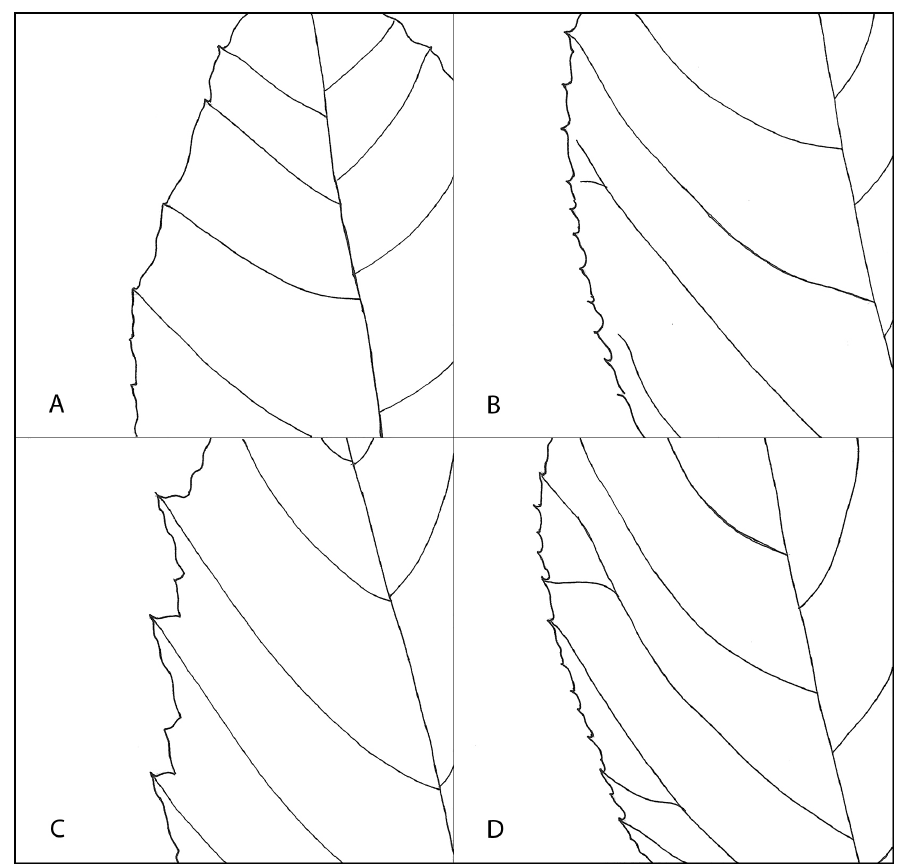
Fig. 3. Outline of Desplatsia Bocq. leaf margins. A . D. subericarpa Bocq. ( Harris 1387 (E)). B . D. chrysochlamys (Mildbr. & Burret) Mildbr. & Burret ( Harris 5402 (E)). C . D. dewevrei (De Wild. & T.Durand) Burret ( Harris 7025 (E)). D . D. mildbraedii Burret ( Harris 4397 (E)). Shown at 1.5 × actual size. Illustrations by Sanna